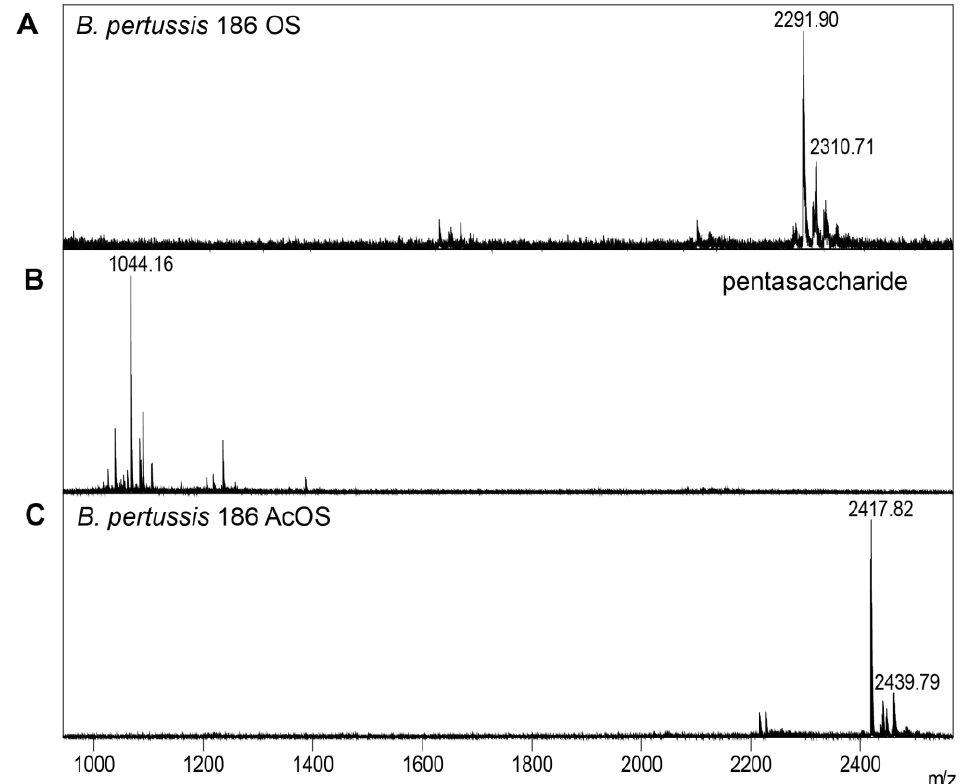
Figure 2. MALDI-TOF MS spectra of B. pertussis 186 LOS-derived oligosaccharides: ( A ) complete native OS (dodecasaccharide), ( B ) pentasaccharide isolated by the deamination of the OS and ( C ) N-acetylated OS. Spectra were recorded in negative ion mode using 2,4,6-trihydroxyacetophenone (THAP) or dihydroxybenzoic acid (DHB) in AcN/0.1% TFA (1:1) as a matrix.